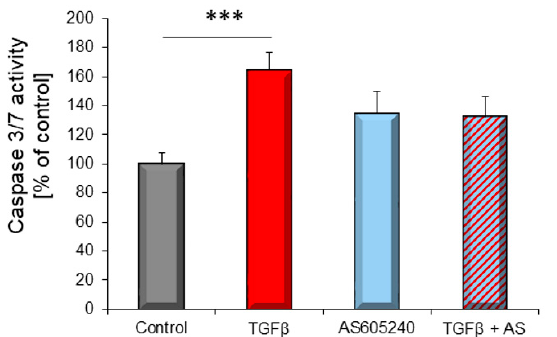
Figure 6. Cardiomyocytes of adult rats were stimulated with 1 ng/mL TGF β 1 for 6 h, with and without addition of PI3K γ inhibitor AS605240 (1 µ M). Quantitative determination of caspase 3/7 activation ( n = 14–16 independent cardiomyocytes preparations). Data are shown as means ± SEM. Significance is indicated by *** p <